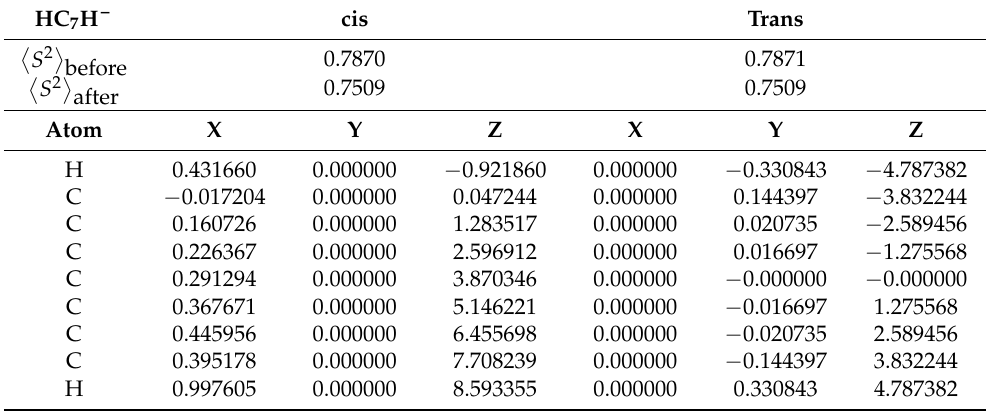
Table A5. Cartesian coordinates in Å of the cis and trans HC 7 H – anion conformers optimized at